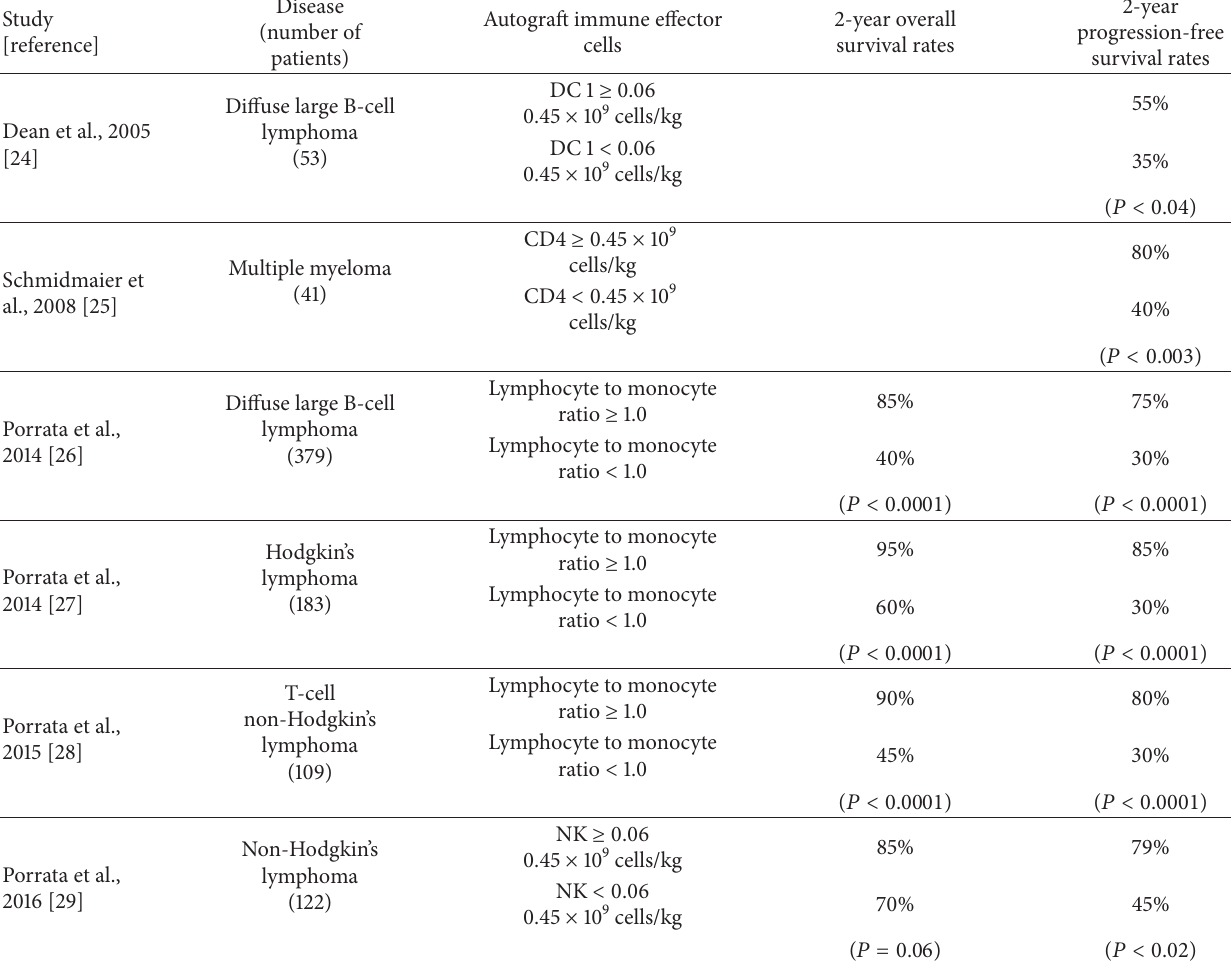
Table 2: Autograft immune effector cells and survival after autologous hematopoietic stem cell transplantation. Study [ reference ]